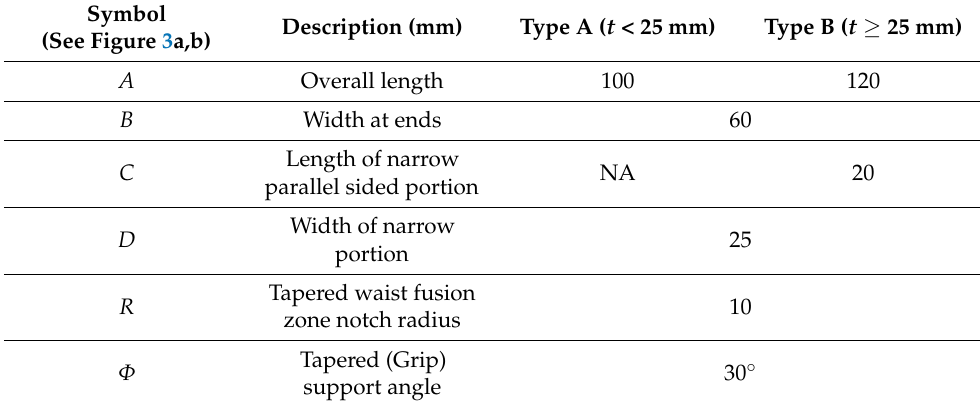
Table 1. Dimensions of TWT specimens.